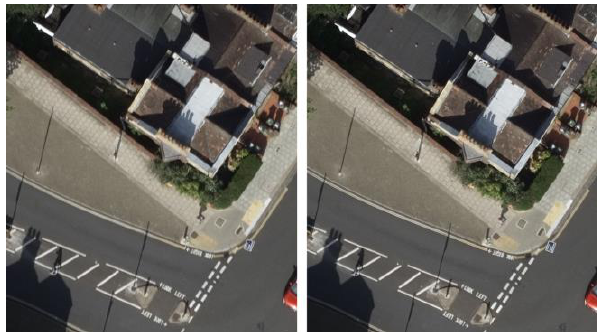
Figure 5 : Street details of one large scale NADIR image (UltraCam Osprey 4.1, GSD nadir 3,5 cm). Motion blur exists due to suboptimal flight conditions (cf. left image) and was successfully compensated by AMC (cf. right image) Another example of an oblique image illustrates how effective AMC works against angular motion compensation. The figure below shows building facades, which are blurred due to angular movement of the camera when the image was taken (left side of Figure 6) and the reconstructed image after applying AMC (right side of Figure 6).